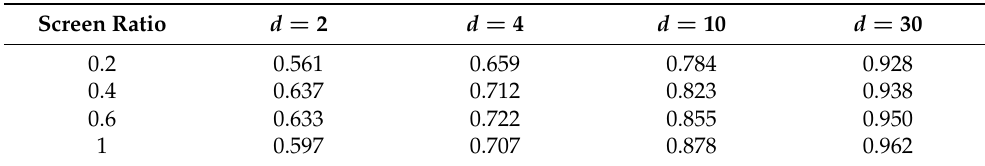
Table A3. Average Spearman Correlation Between Stage 1 and Stage 2 p -values in Simulation. Average Sequencing Depth d =